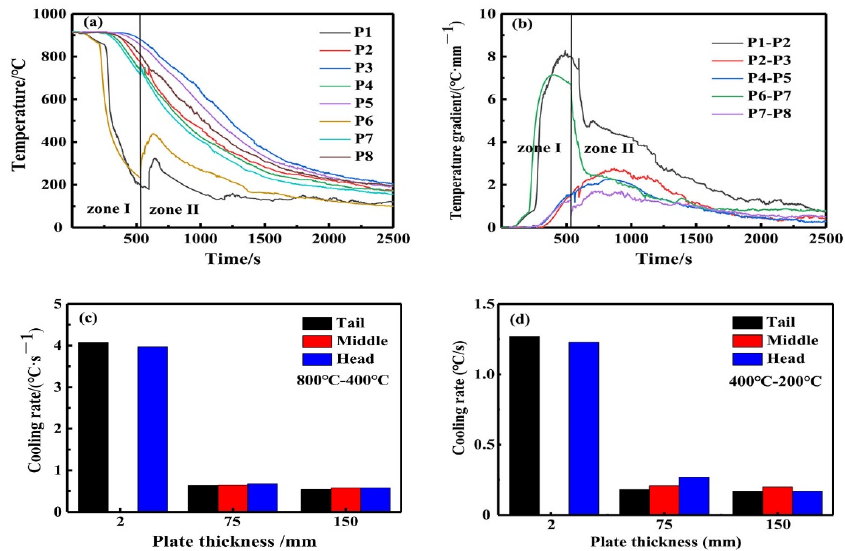
Figure 3. Cooling curves during quenching: ( a ) temperature versus time at the different measurement points; ( b ) temperature gradient along the plate thickness; ( c ) high temperature range cooling rate; ( d ) low-temperature range cooling rate.